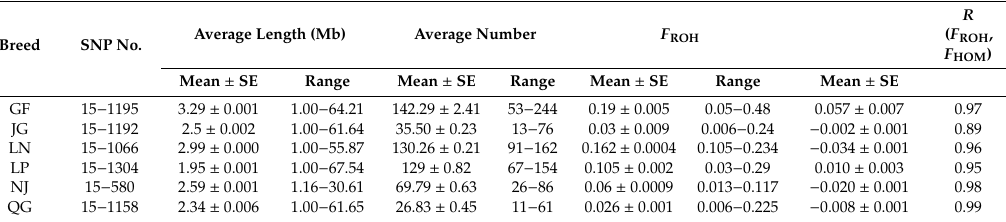
Table 2. Descriptive statistics for runs of homozygosity and inbreeding coefficients (F) within each breed. SE, standard error; F ROH , inbreeding coefficient based on runs of homozygosity (ROH); F HOM , Inbreeding coefficient based on the difference between the observed and expected numbers of homozygous genotypes ; R, correlation; GF, Guangfeng; JG, Jinning Grey; LN, Liaoning; LP, Luoping Yellow; NJ, Nanjiang; and QG, Qinggeli .